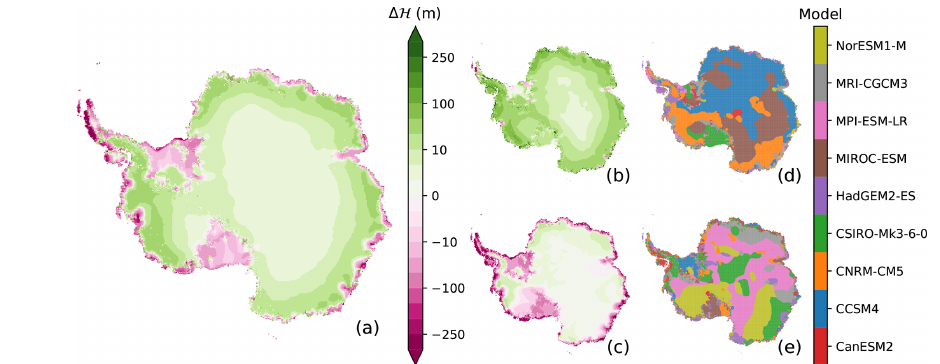
Figure 10. Ice thickness changes since 1850 under the RCP8.5 scenario for applied precipitation anomalies in the year 2200. The ensemble mean (a) , ensemble maximum (b) , and ensemble minimum (c) are highlighted. The climate models that were used to drive the ice sheet model simulation causing the maximum and minimum thickness are shown in panels (d) and (e) , respectively, next to the ensemble maximum (b) and minimum (c) .